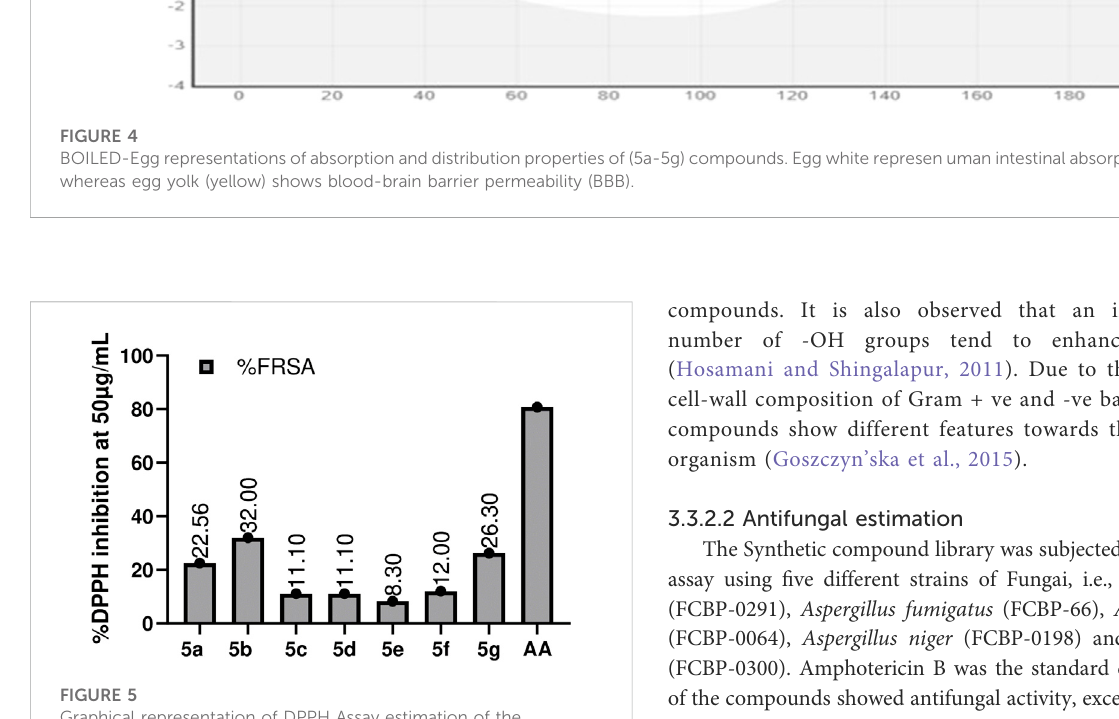
Table 4 3.12 μ g/mL was for 5f . 5a, 5b (MIC = 12.5 μ g/mL) , 5e (MIC = 3.12 μ g/mL, same as Cipro fl oxacin ) were active against Pseudomonas aeruginosa, and 5c, 5d, 5e (MIC = 25 μ g/mL) were